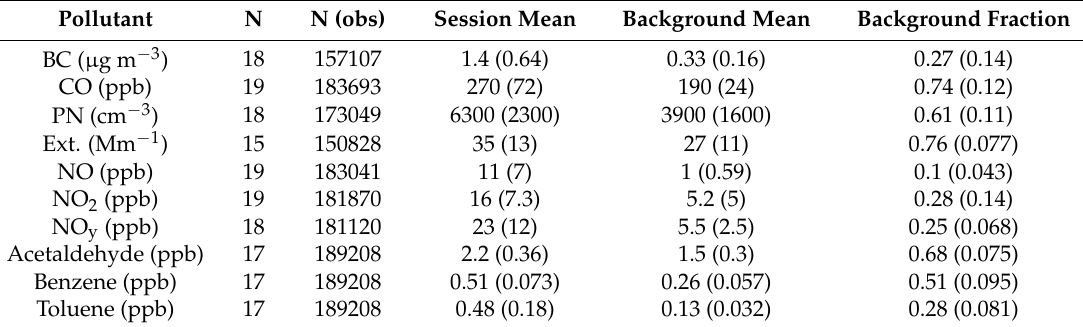
Table 2. Summary of measured pollutant concentrations by session. Column “N” represents number of sessions while N (obs) is number of observations. The grand means of the observed concentrations, estimated background concentrations, and proportion of the mean concentration attributed to background are given in the last three columns. Numbers in parentheses represent the standard deviations of the session